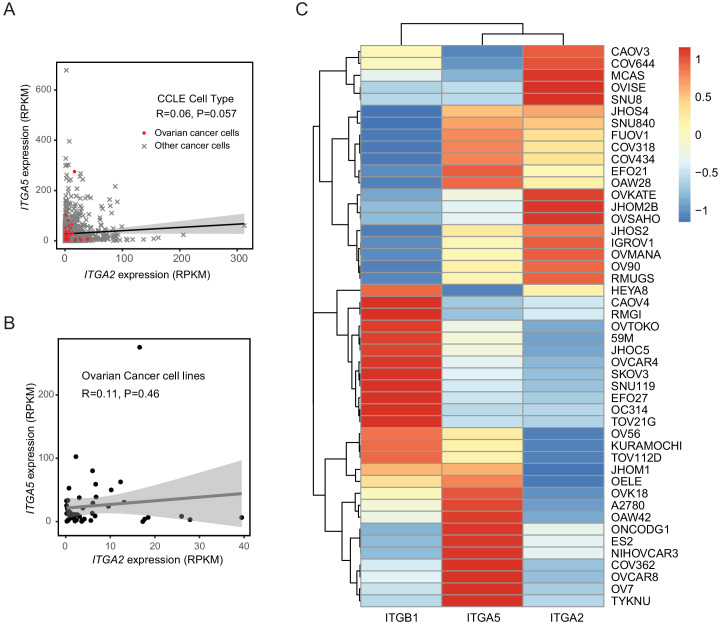
ITGA2 expression does not correlate with the expression of ITGA5.Spearman’s correlation coefficient in scatter plot showing ITGA2 and ITGA5 (RPKM) expression in (A) all cancer cell lines (EOC cell lines highlighted red) and (B) EOC cell lines in CCLE dataset (C) Hierarchical cluster analysis and heat map visualization of selected integrins ITGA2, ITGB1, and ITGA5 among EOC cell lines using the CCLE dataset.